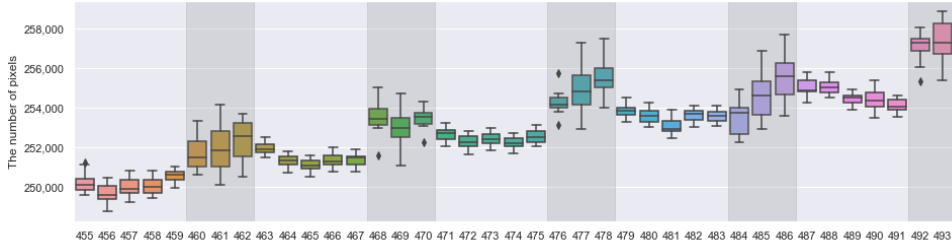
Figure 14. The box-plot of the 11 measurements (see Figure 12a) during the period 8–12 October 2020. The variance is higher in the evening (17:49, 19:49, 21:49), indicated by the darker background. The higher the variance, the longer the box and the whisker, and the more individual the points. The horizontal line in each box represents the median. The images captured on the last day (from 487 to 494) are found in Figure 15.